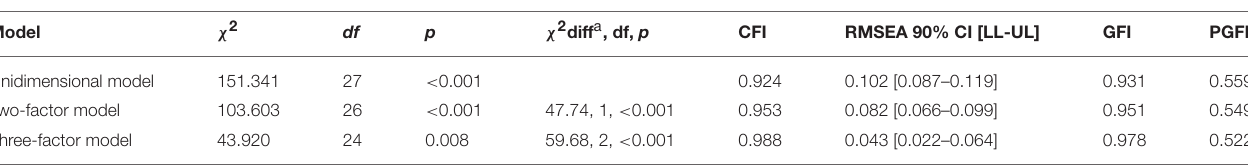
TABLE 3 | Goodness-of-fit statistics for tested